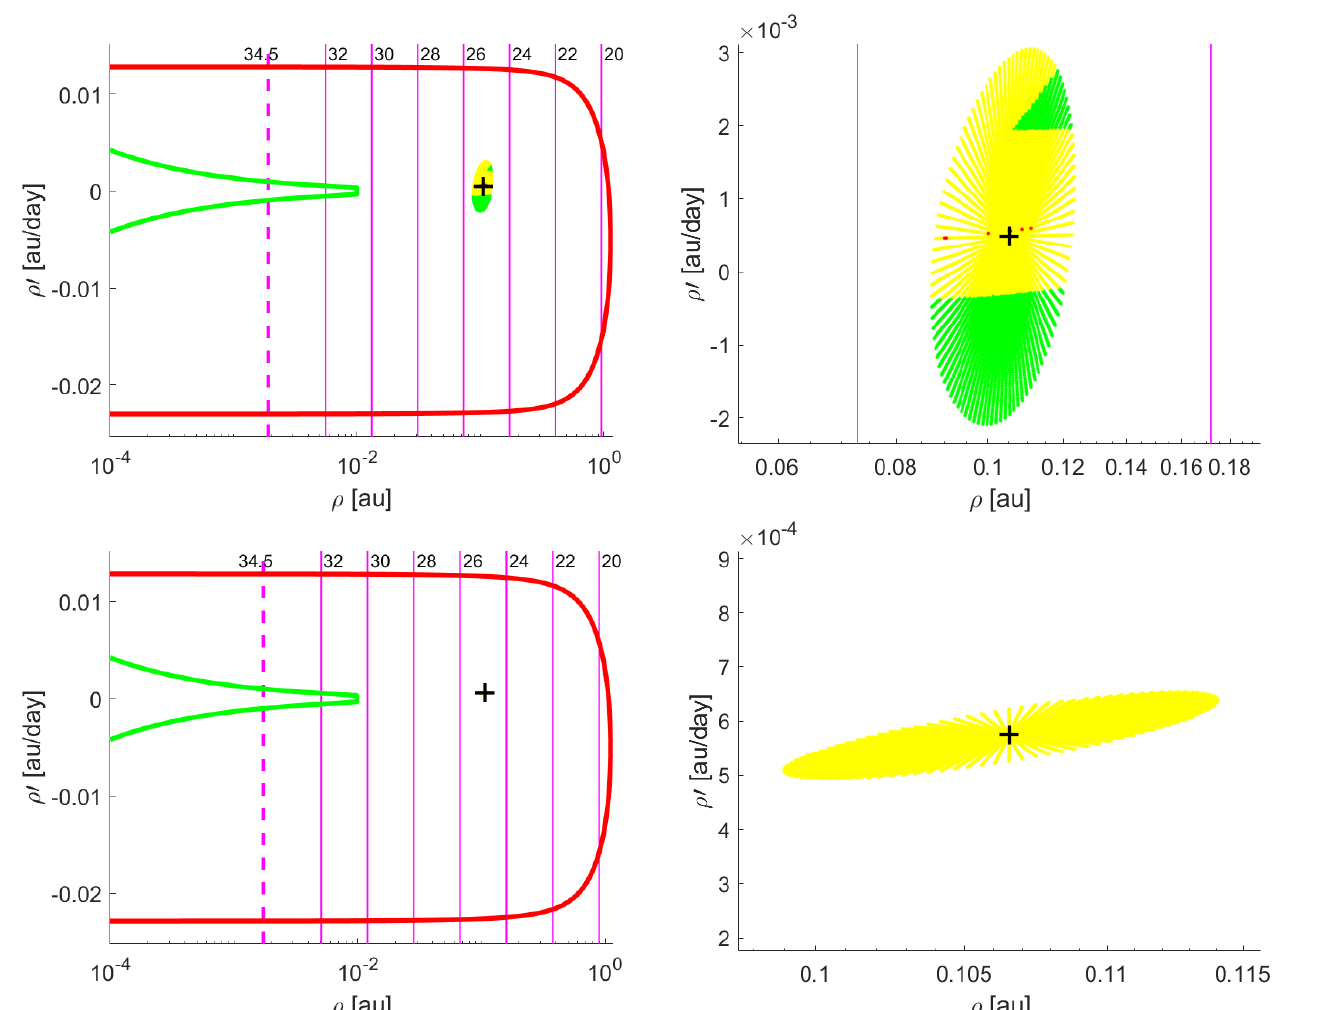
Figure 8. Tool 1 tested on asteroid 2012PB 20 . Top panels show the output of a run with four observations as it appears on the AR (left) and zooming in on the MOV points (right). Analogously, bottom panels show the output for a test over eight observations, yielding low IP since no point shows MOID ď 5 ˆ 10 ´ 5